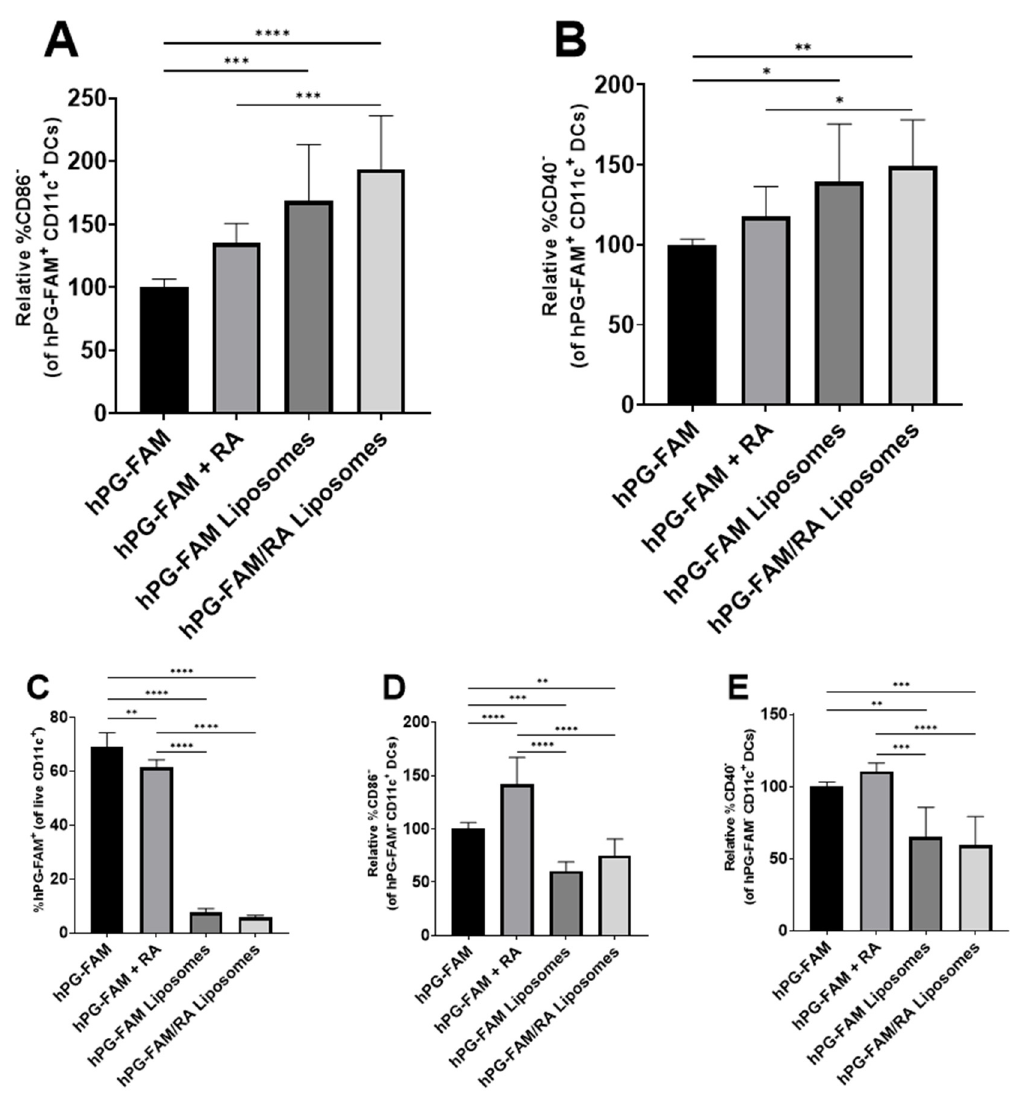
Figure 3. Encapsulation of hPG in liposomes skews towards tolDCs within antigen-associated BMDCs. BMDCs were stimulated with LPS and cultured in the presence of hPG-FAM, hPG-FAM + RA, hPG-FAM liposome or hPG-FAM/RA liposomes. After 24 h of incubation, cells were washed thoroughly and analyzed by flow cytometry. ( A ) Relative % CD86 − (normalized to hPG-FAM control) and ( B ) CD40 − tolDCs within hPG-FAM + cells. ( C ) Percentage of live BMDCs positive for FAM. ( D ) Relative %CD86 − (normalized to hPG-FAM control) and ( E ) CD40 − tolDCs within hPG-FAM − cells. Means + SD, **** p < 0.0001, *** p < 0.001, ** p < 0.01, * p < 0.05 compared to hPG-FAM determined by one-way ANOVA and Tukey’s multiple comparisons test. The data shown are combined normalized data from three independent experiments.